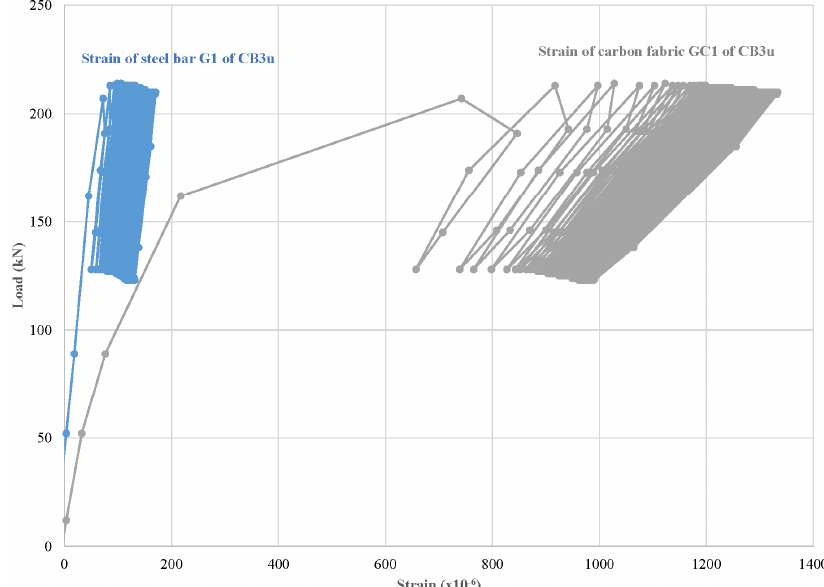
Figure 6: Strains of steel and carbon fiber fabrics of strengthened corbels under fatigue